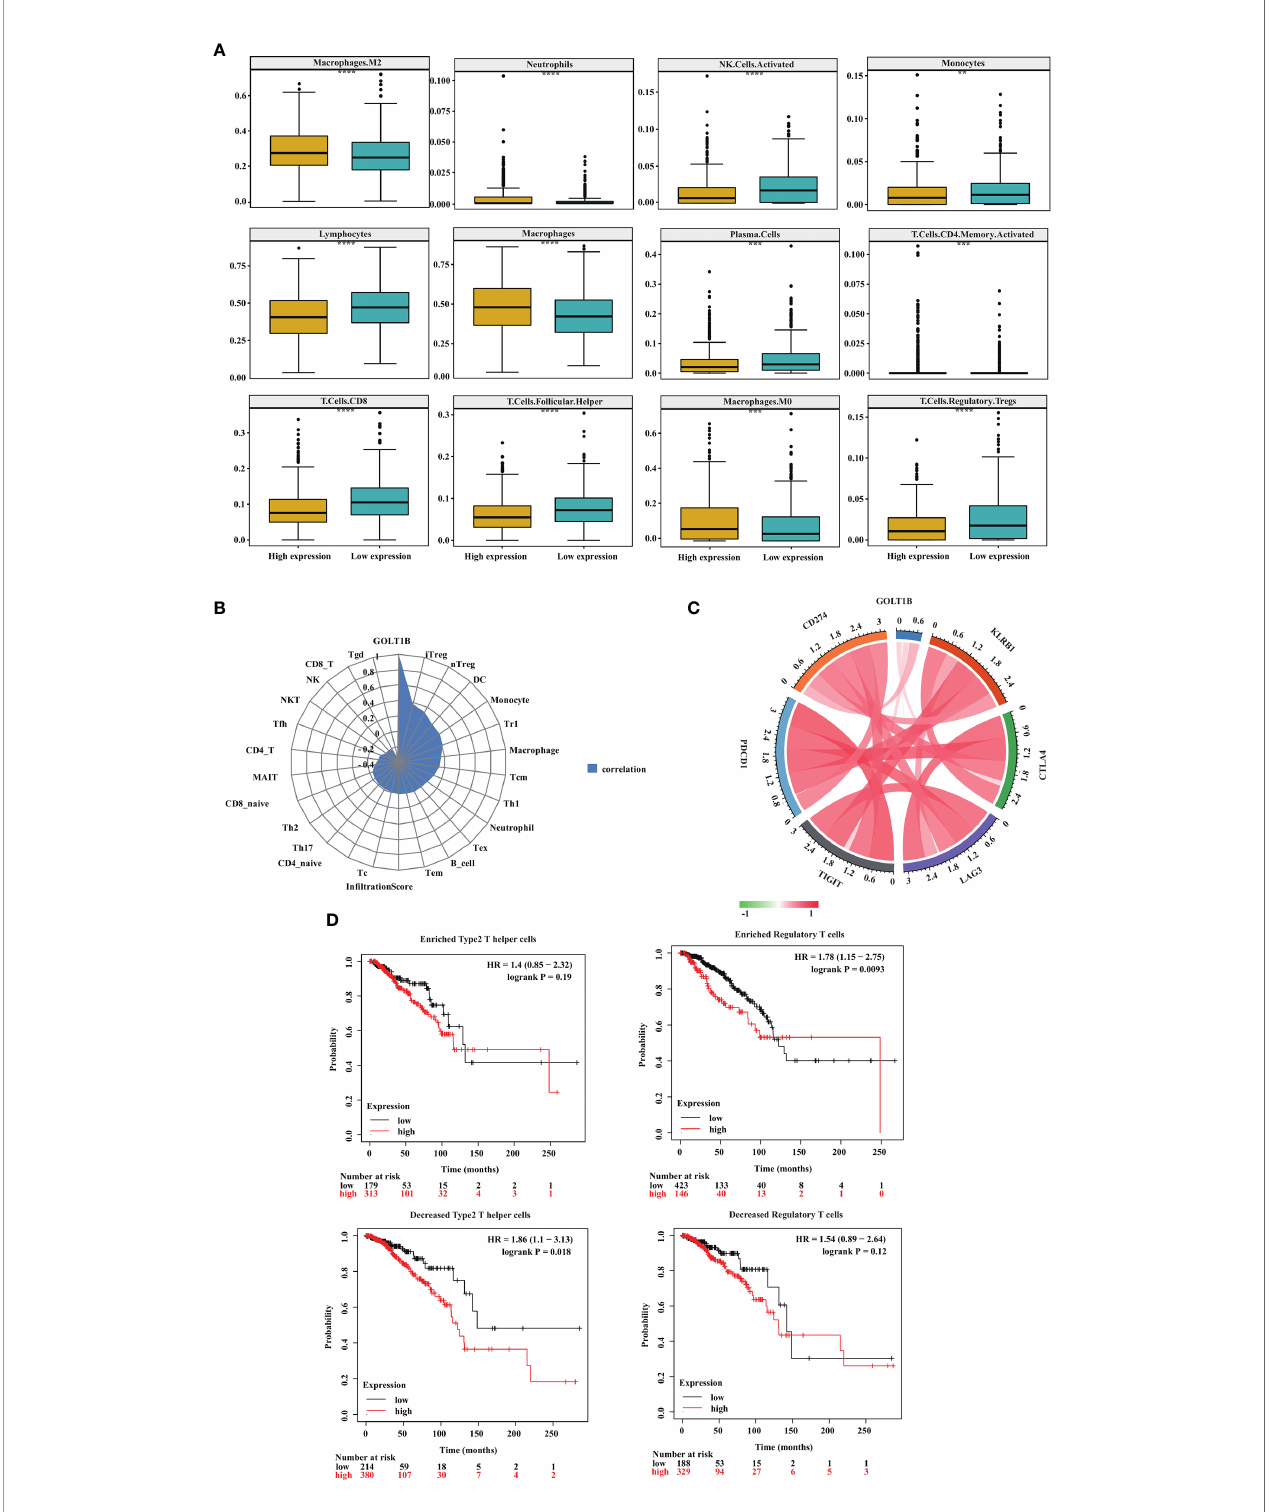
FIGURE 6 | GOLT1B expression is potentially associated with immune in fi ltration in breast cancer patients. (A) The correlation between the GOLT1B expression and in fi ltration of immune cells in breast cancer was analyzed using the TIMER database. (B) The correlation between the GOLT1B expression and in fi ltration of immune cells in breast cancer was analyzed using the CIBERSORT database. (C) The correlation between the expression of GOLT1B and immune checkpoints in human breast cancer. (D) The correlation between the expression of GOLT1B and OS of breast cancer patients with different in fi ltration of immune